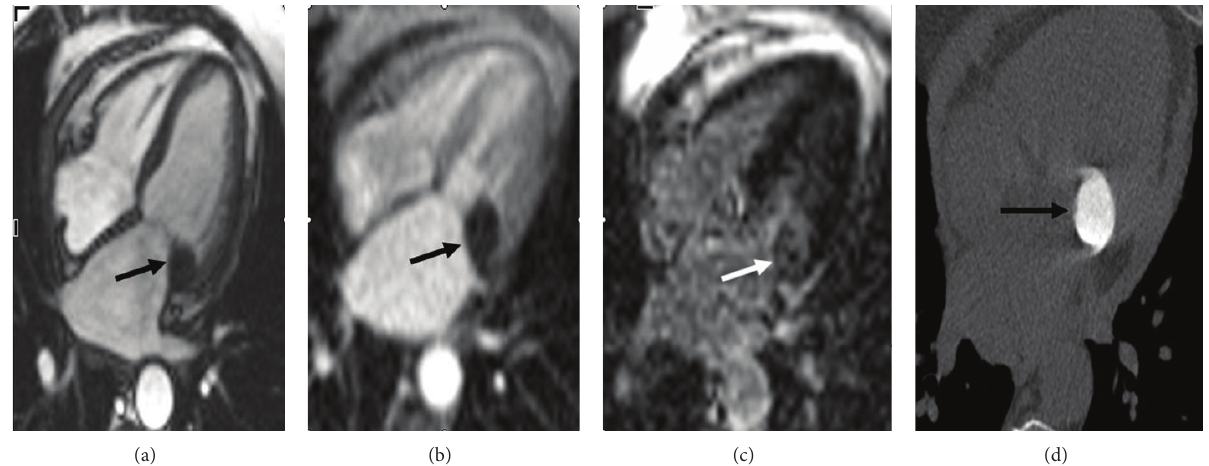
Figure 2: Balanced steady state free precession (SSFP) sequence image (a) shows hypointense lesion with well-defined borders (black arrow). First pass image (b) demonstrates no contrast enhancement. Delayed phase postcontrast phase sensitive inversion recovery (PSIR) image (c) shows peripheral enhancement. Multidetector cardiac CT image for calcium scoring (d) shows diffuse calcific lesion with well-defined borders located in mitral annulus (black